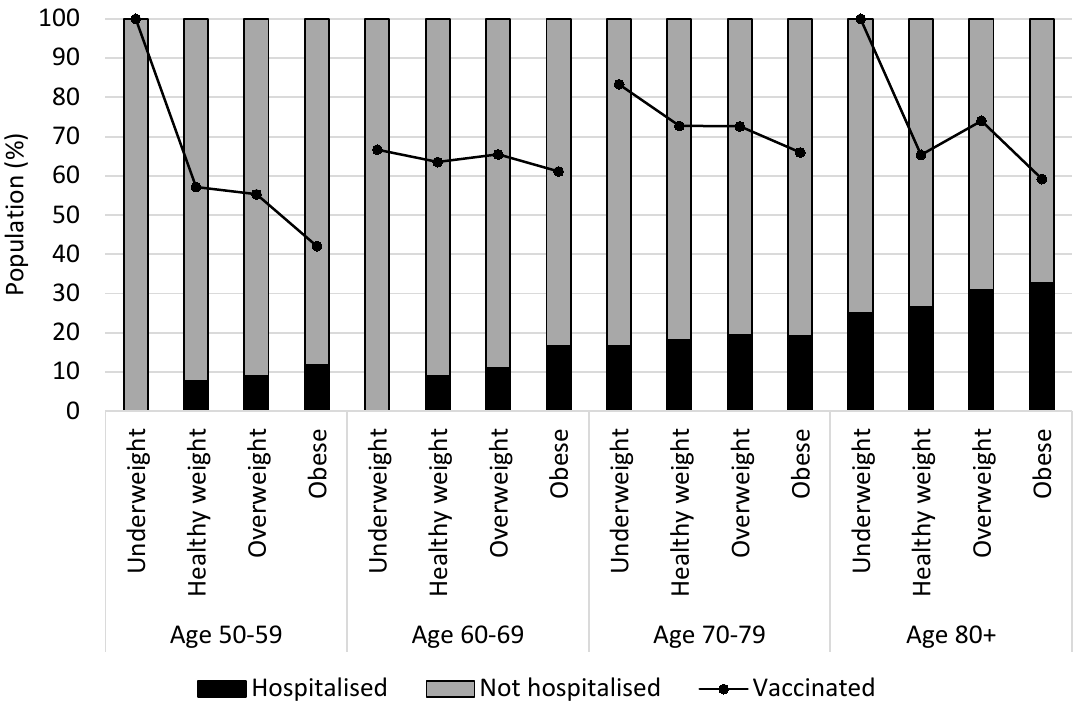
Figure 3. Hospitalization and vaccination status by BMI and age groups ( N = 1936).